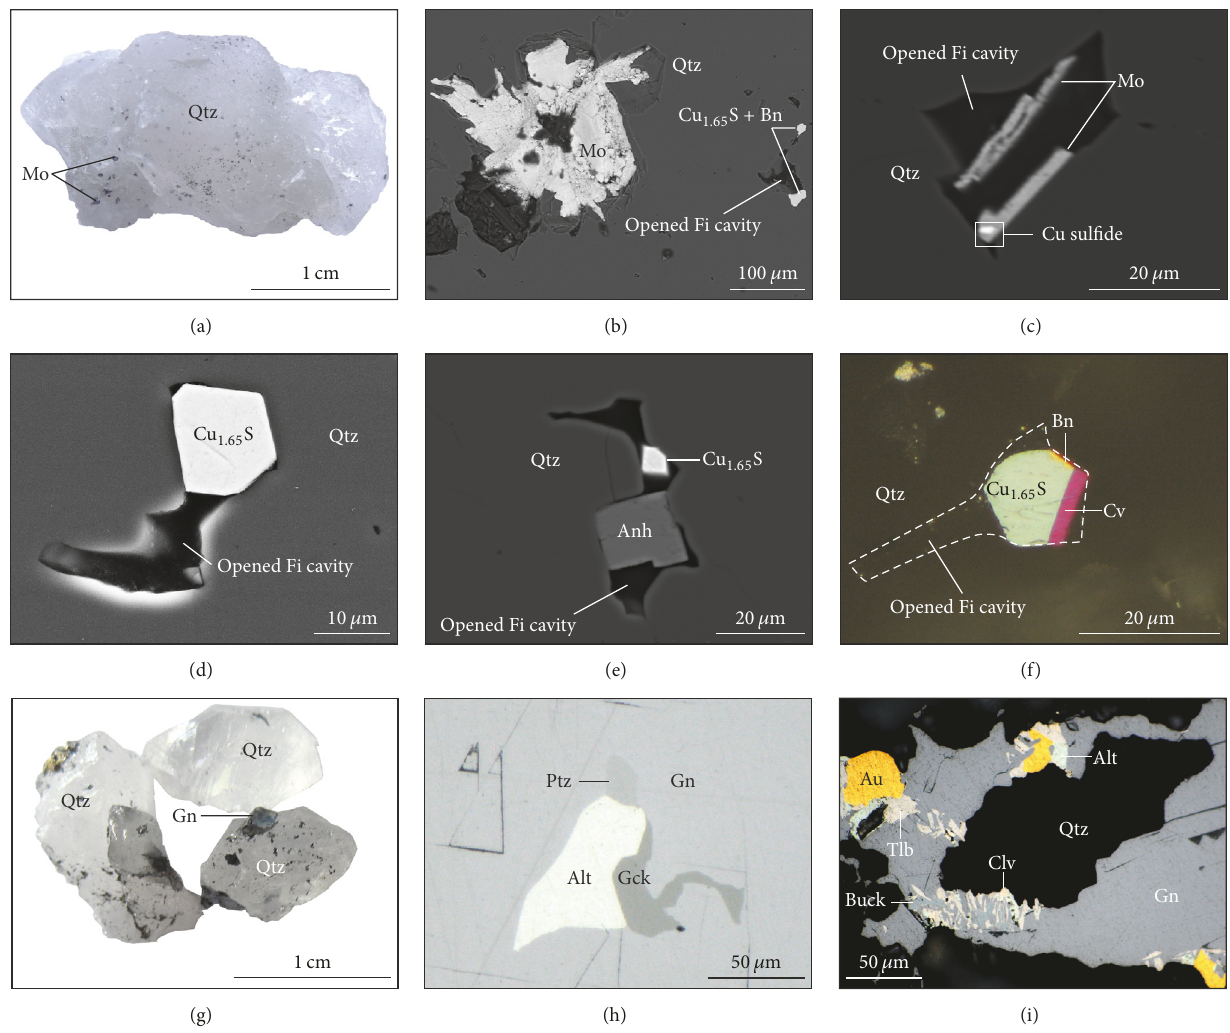
Figure 2: Vein mineralogy of Dahu stage I and stage III mineralization. (a) Stage I quartz crystals with abundant molybdenite mineral inclusions. Sample LS-540-3. (b) Backscattered electron (BSE) image showing molybdenite occurring as larger mineral inclusions in stage I quartz while Cu 1.65 S and bornite occur as smaller solids in opened fluid inclusions. Sample LS-540-3. (c)–(e) BSE images and (f) plane- polarized reflected light photomicrograph showing solids including molybdenite, Cu 1.65 S, covellite, bornite, and anhydrite in opened fluid inclusions in stage I quartz. Sample LS-540-3. (g) Stage III quartz crystals in contact with galena. Sample 470-F7-13. (h) Plane-polarized reflected light photomicrograph showing aggregate of altaite, greenockite, and petzite in galena. Sample 470-F7-13. (i) Plane-polarized reflected light photomicrograph showing gold and tellurides in galena. Sample 400-10. Alt = altaite, Anh = anhydrite, Au = gold, Bn = bornite, Buck = buckhornite, Cv = covellite, Clv = calaverite, Fi = fluid inclusion, Gck = greenockite, Gn = galena, Mo = molybdenite, Ptz = petzite, Py = pyrite, Qtz = quartz, and Tlb =